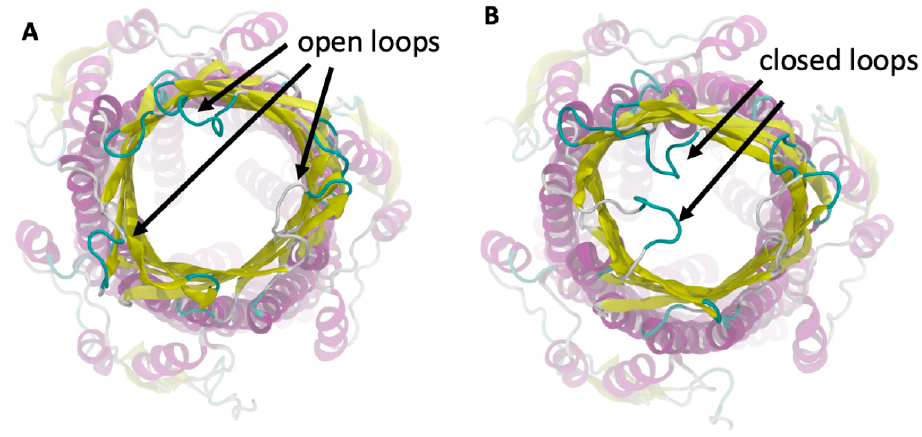
Figure 7. Outer membrane domain of the ST50 protein in the open ( A ) and closed ( B ) position.